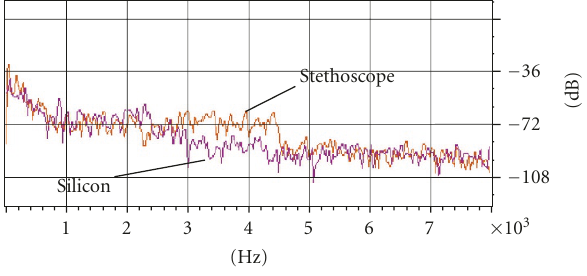
Figure 7: Long-term power spectrum of o ffi ce noise at 70 dBA level captured by NAM microphones.